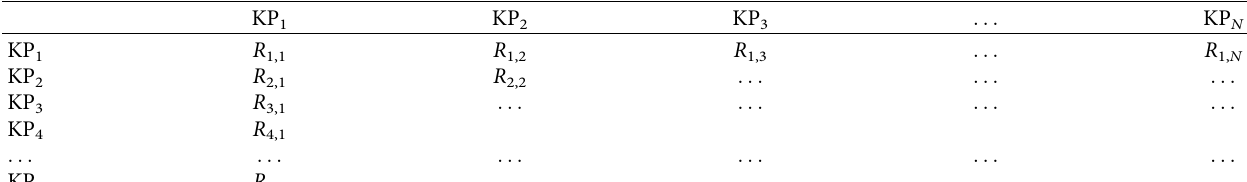
Table 2: Keyword correlation matrix.